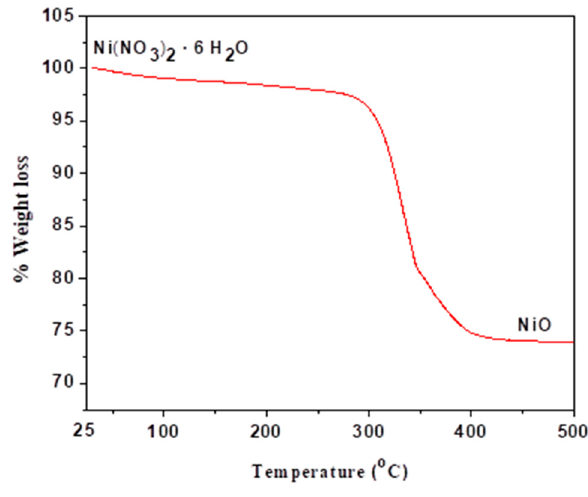
Figure 6. TGA thermogram of the decomposition of nickel nitrate hexahydrate under air .